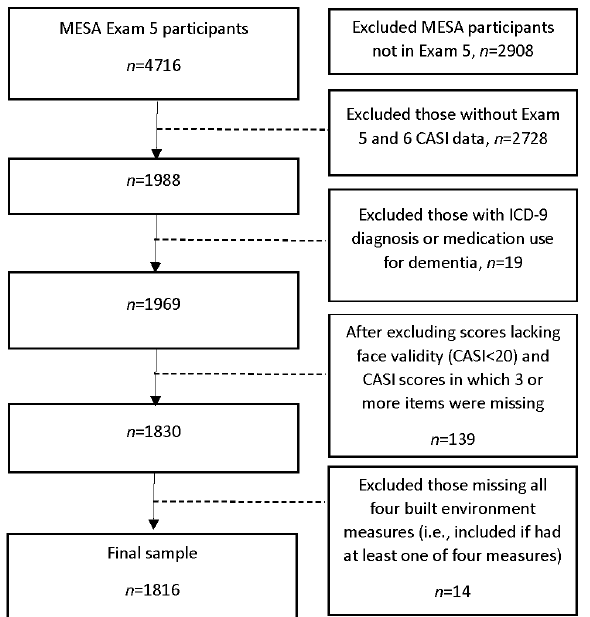
Figure 1. Sample size flow diagram. Abbreviations: MESA = Multi-Ethnic Study of Atherosclerosis; CASI = Cognitive Abilities Screening Instrument; ICD = International Classification of Diseases. Table 1. Participant characteristics.